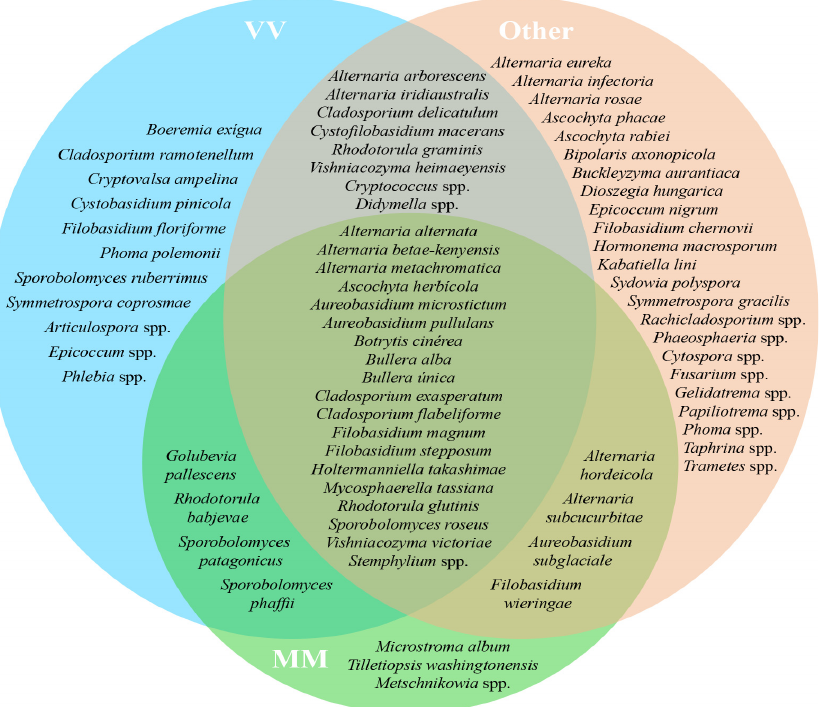
Figure 4. Venn diagram representing shared core taxa of fungi found on grape surface from ten Portuguese vineyard parcels from different regions/sub-regions, Monção and Melgaço (green area), Vinho Verde region (blue area) and Other (red area). Only taxa that are common to 100% of the parcels from a specific group (MM, VV or Other) are